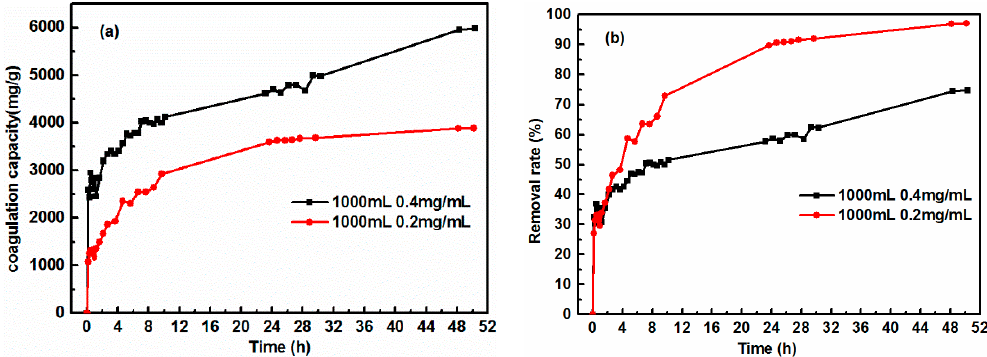
Figure 3. ( a ) Coagulation capacity, and ( b ) removal rate of GO vs. contact time using 0.05 g cement with the GO volume of 1000 mL, 0.2 and 0.4 mg/mL, respectively.